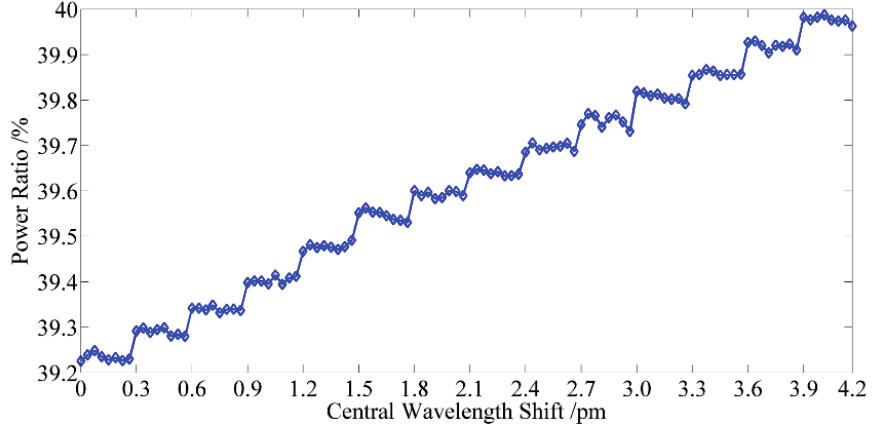
Figure 13. Experimental result of the wavelength resolution of the interrogation